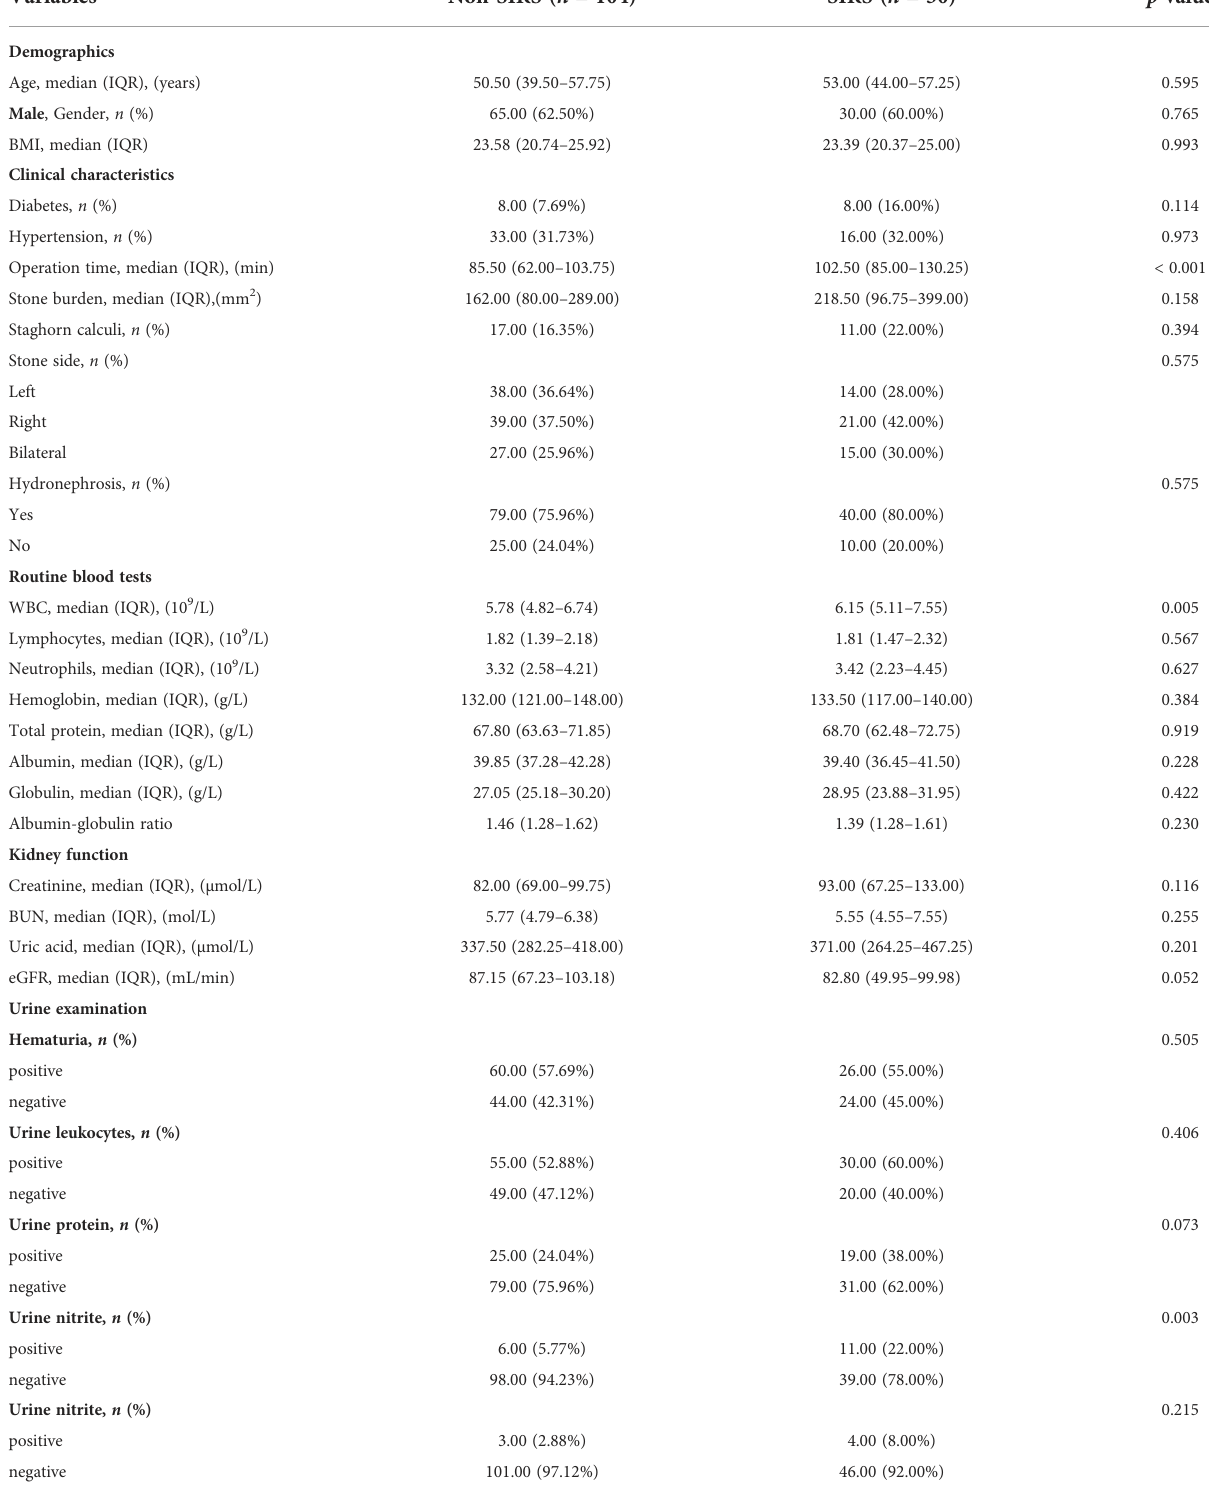
TABLE 1 Basic characteristics data in the non-SIRS group and the SIRS